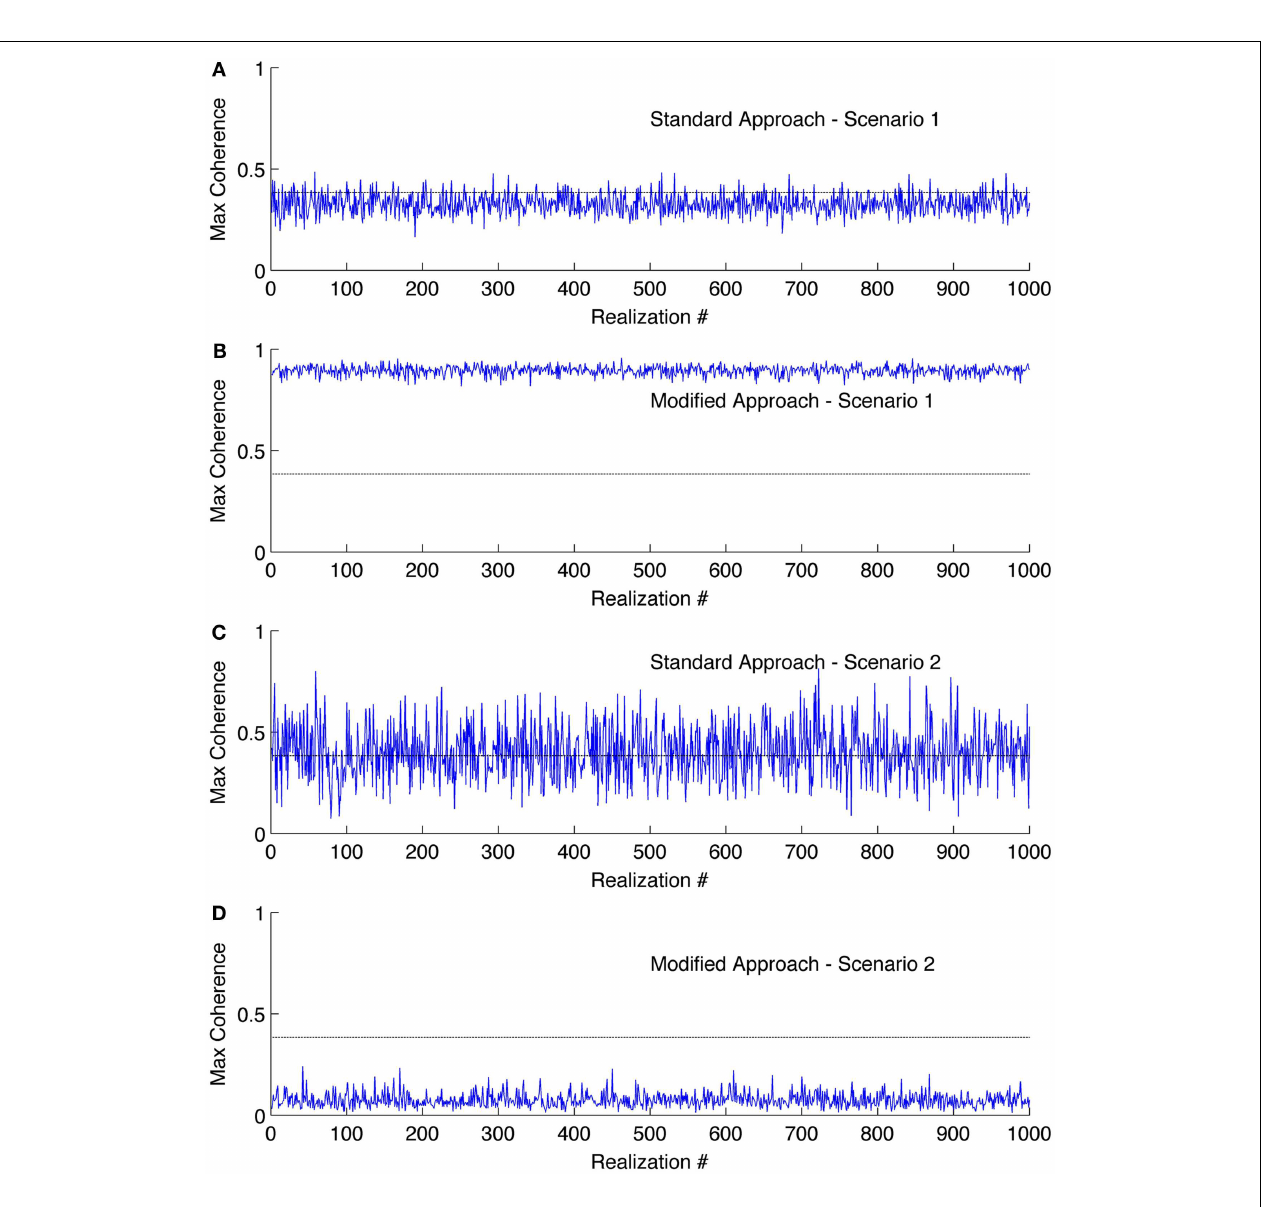
0.05–0.25Hz for scenario 2 using (C) standard approach and (D) the modified approach.The horizontal line at the coherence value of 0.384 is the confidence limit for coherence